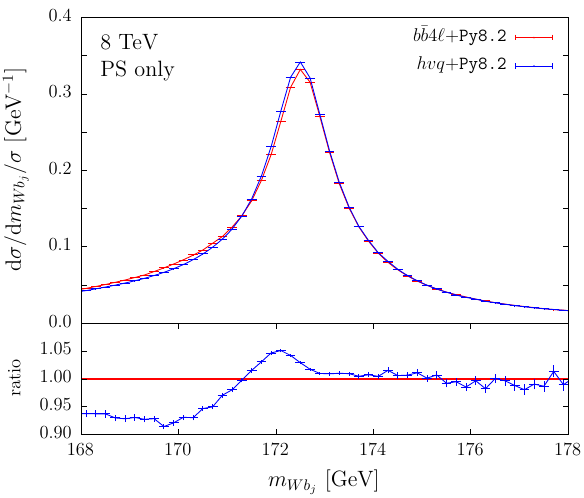
Fig. 6 d σ/ dm Wb distribution,normalizedto1inthedisplayedrange, j obtained with b ¯ b 4 (cid:4) (red) and h v q (blue) at the NLO+PS level using Pythia8.2